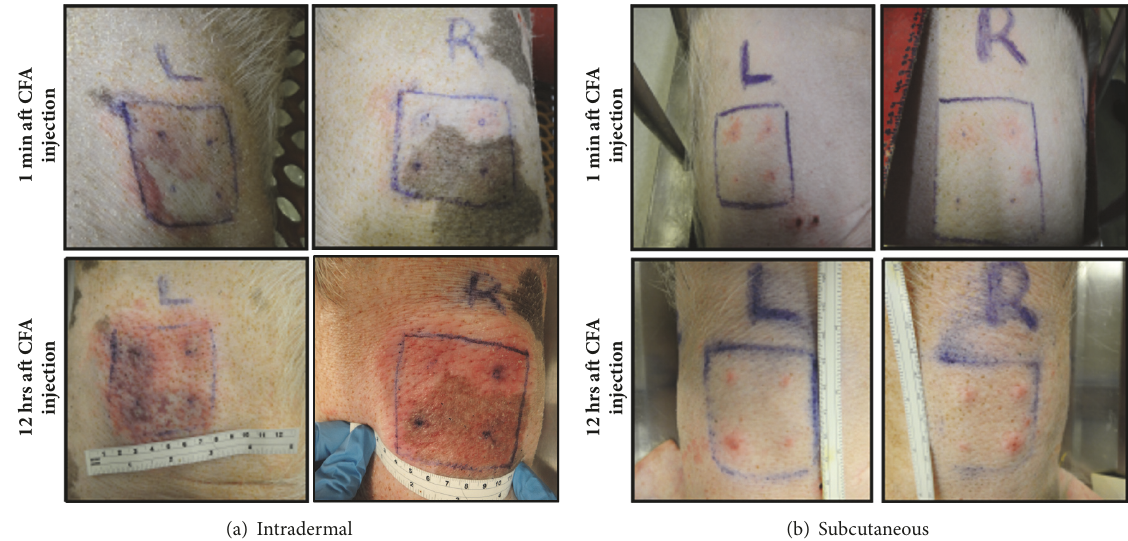
Figure 1: Early reaction of CFA injection after intradermal injection (a) and SC injection (b). Figure depicts both sites of injection at 1 min and 12hrs after CFA injection.